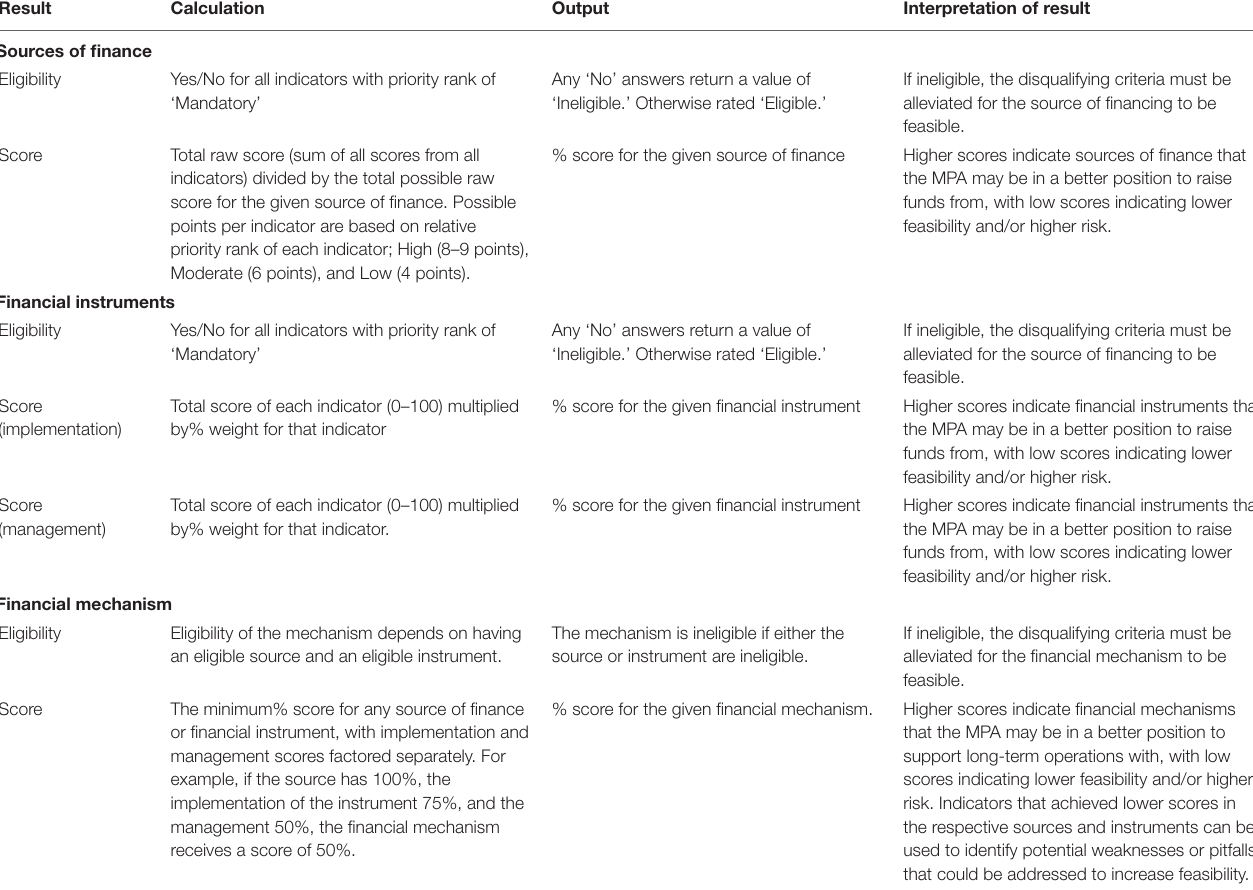
TABLE 1 | Description of calculations, outputs, and how to interpret results for eligibility requirements and scores for sources, instruments, and financial